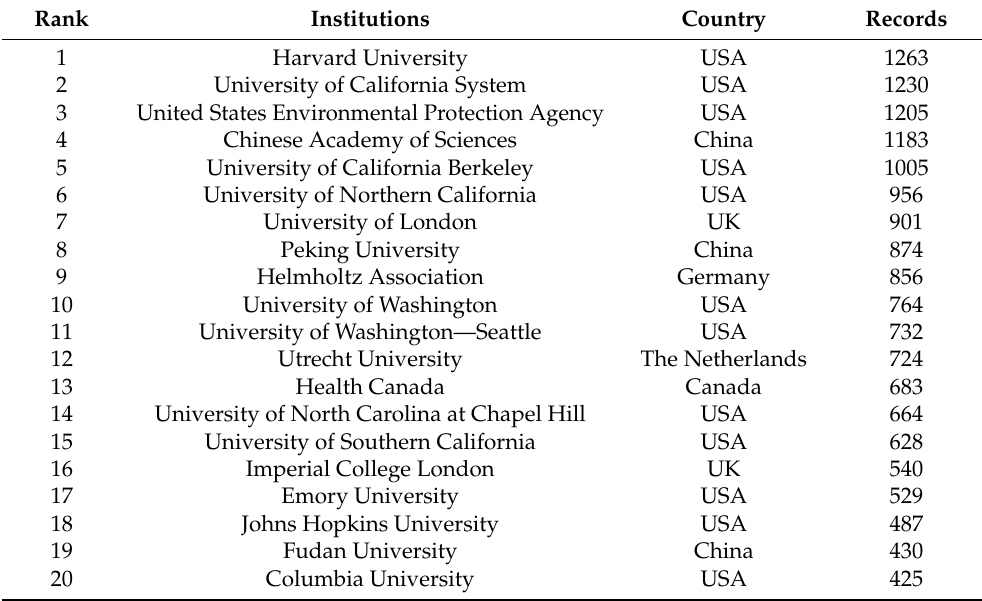
Table 2. The top 20 most productive